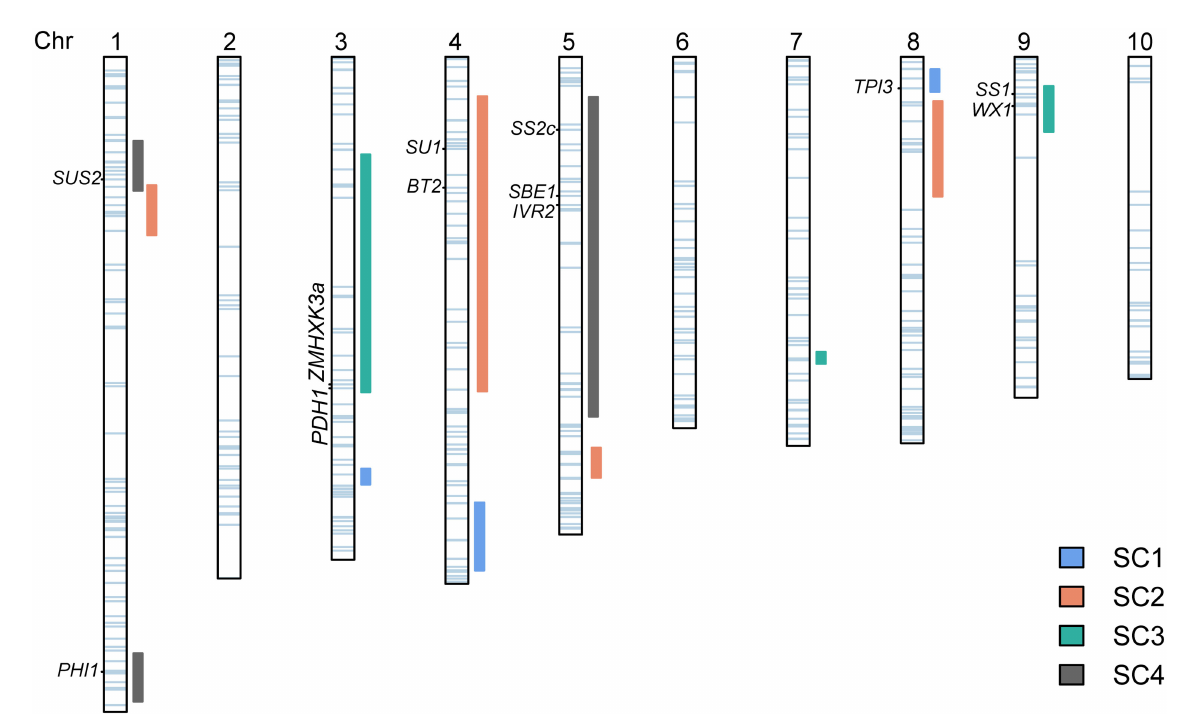
FIGURE4 Association of candidate genes with kernel starch QTLs. The QTLs identified in four DH populations are represented as vertical rectangles of different colors next to each chromosome. The horizontal light blue bars on each chromosome show the positions of the 471 identified genes. The left labels denote known genes that co-localized with the QTLs. The vertical dark green lines indicate the positions of 12 well-known genes encoding key enzymes in maize starch